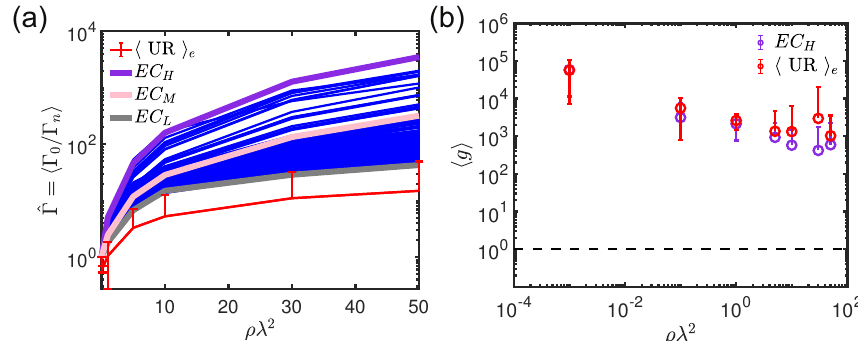
Figure 6. ( a ) Averaged modal lifetime as a function of different optical densities of the 900 EC geometries generated by all the possible combinations of the coefficients A and B in the range ( 1,30 ) as compared to the uniform random configuration ensemble averaged over 10 different disordered realizations (red curve). The highest ( EC H ), the middle ( EC M ), and the lower ( EC L ) ˆ Γ trend are highlighted in violet, pink and grey color, respectively. In particular, EC H , EC M , and EC L are the elliptic curves over the finite field F 2111 generated by the parameters combination ( a = 27; b = 4; ) , ( a = 11; b = 8; ) , and ( a = 28; b = 19; ) respectively. ( b ) Thouless conductance as a function of the scattering strength ρλ 2 averaged over the frequency stripe of width 2 Γ 0 centered in ω 0 for the EC H (circle violet markers) and UR (circle red markers) configurations, respectively. The dashed-black lines identify the threshold of the diffusion-localization transition g =